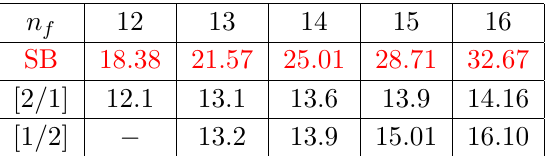
for QCD with n = 2 . In all cases ∆ e F < 0 conf 3 c